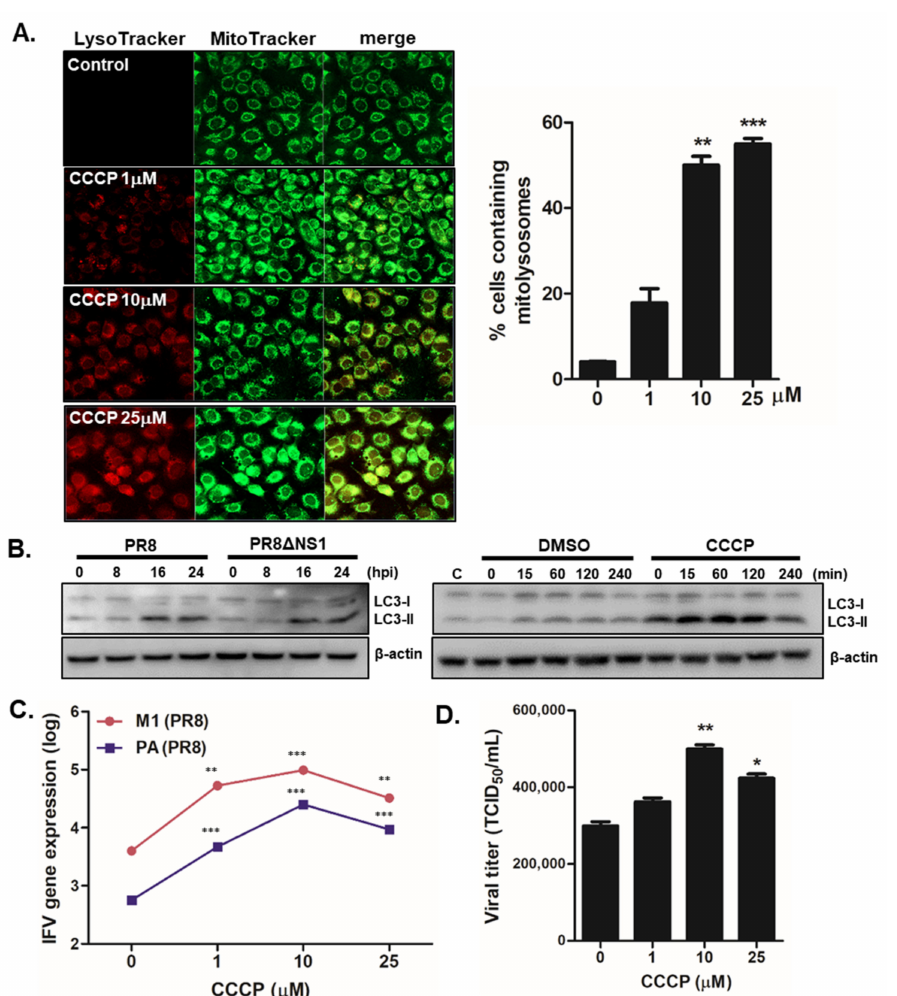
Figure 2. CCCP-mediated mitophagy activation enhances viral replication in A549 cells ( A ) Cells were treated with various concentration of CCCP for 2 h and subsequently stained with MitoTracker Green (500 nM) and LysoTracker Red (75 nM). Scale bar = 20 µ m. % cells containing mitolysosomes were measured and are presented in the graph. ** p < 0.01; *** p < 0.001, vs. DMSO-treated cells. ( B ) A549 cells were infected with PR8 or PR8dNS1 at an MOI of 1 for indicated times (left) or were treated with 25 µ M CCCP for indicated times (right). Immunoblot analysis of LC3 is shown. ( C ) Cells were pretreated with different concentrations of CCCP for 2 h and infected with PR8 virus at MOI of 1 for 24 h. IFV matrix protein 1 (M1) and polymerase protein (PA) copy numbers were quantitated by qRT-PCR, normalized, and analyzed (means ± SD; n = 3). * p < 0.05; ** p < 0.01; *** p < 0.001, vs. DMSO-treated cells. ( D ) Viral titers were measured using the TCID50 assay and expressed as TCID50/mL (means ± SD; n =